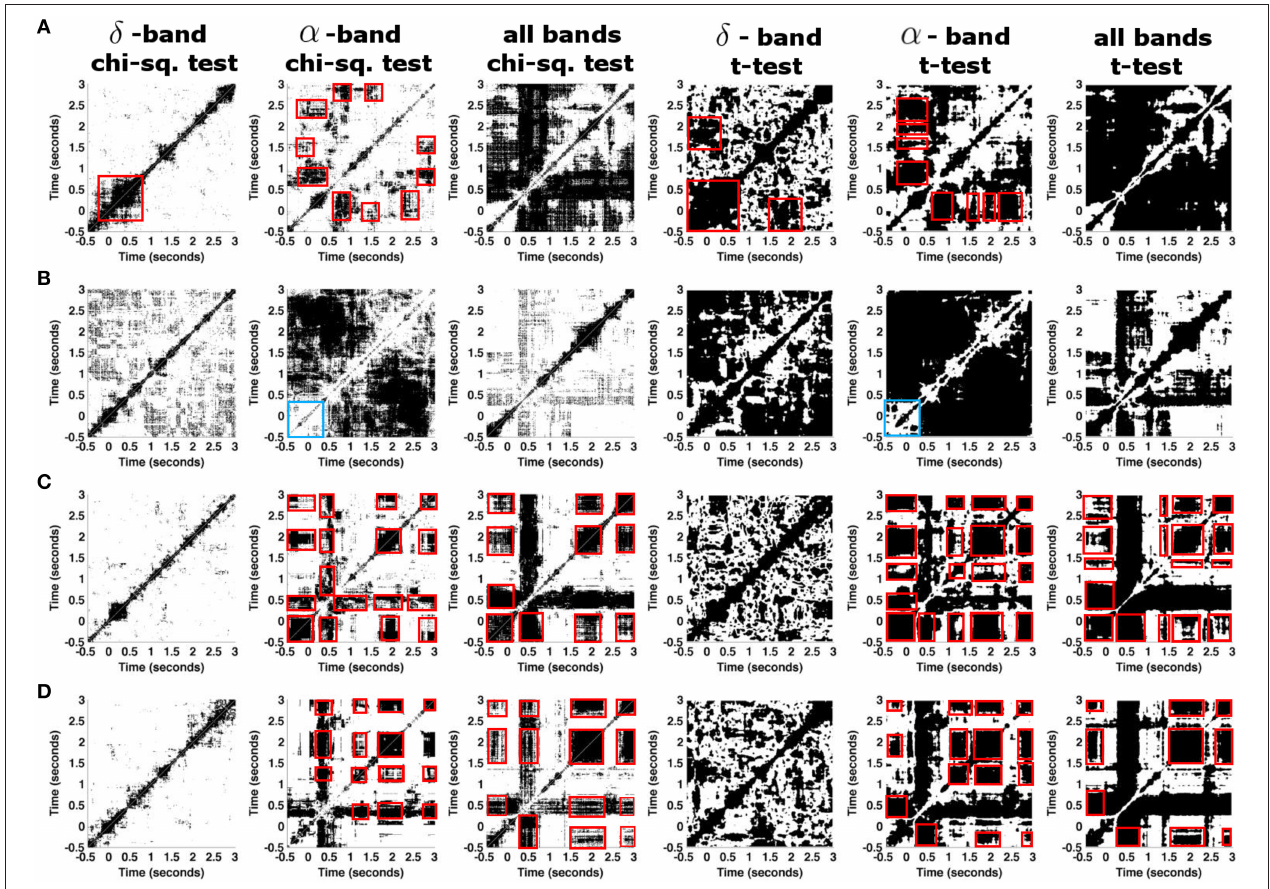
FIGURE 7 | Statistically significant parts of recurrence plots for different ferret datasets. (A) Results from a dataset of session one that consists of 10 trial recordings of the single granular sensor s 10 . (B) Same as in (A) for the dataset session two . (C) Results are calculated based on 10 averaged trials in dataset session one , where each trial is averaged over 8 granular layer time series. (D) Same as in (C) for dataset session two . Red boxes indicate MSs, blue boxes in (B) indicate a prominent lack of recurrence in the α −